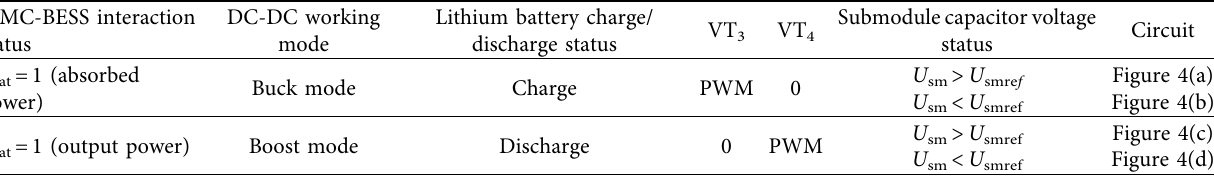
Table 1: MMC-BESS interaction status and energy storage system working